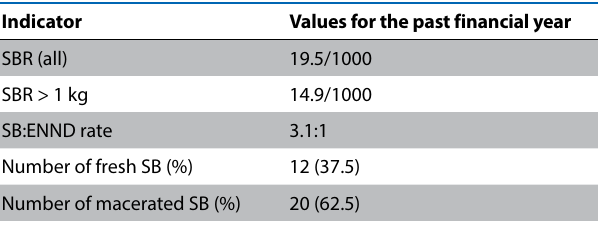
Table l: Analysis of Perinatal Problem Identification Programme data in your sub-district